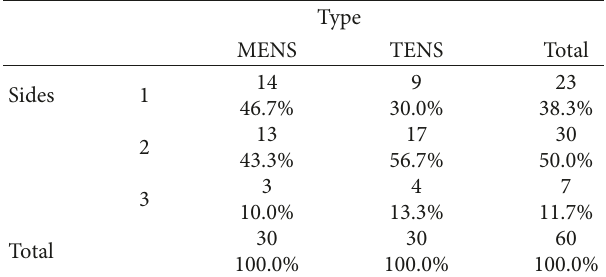
Table 2: Affected side distribution among the study population. Right side is represented by 1, left side by 2, and 3 represents both right and